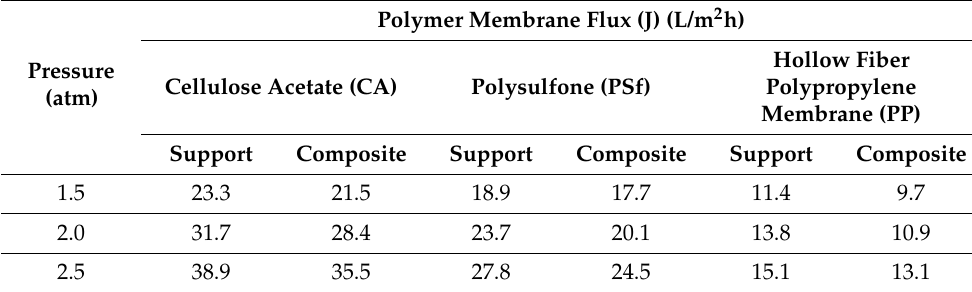
Table 3. The flow characteristics of the composite and support